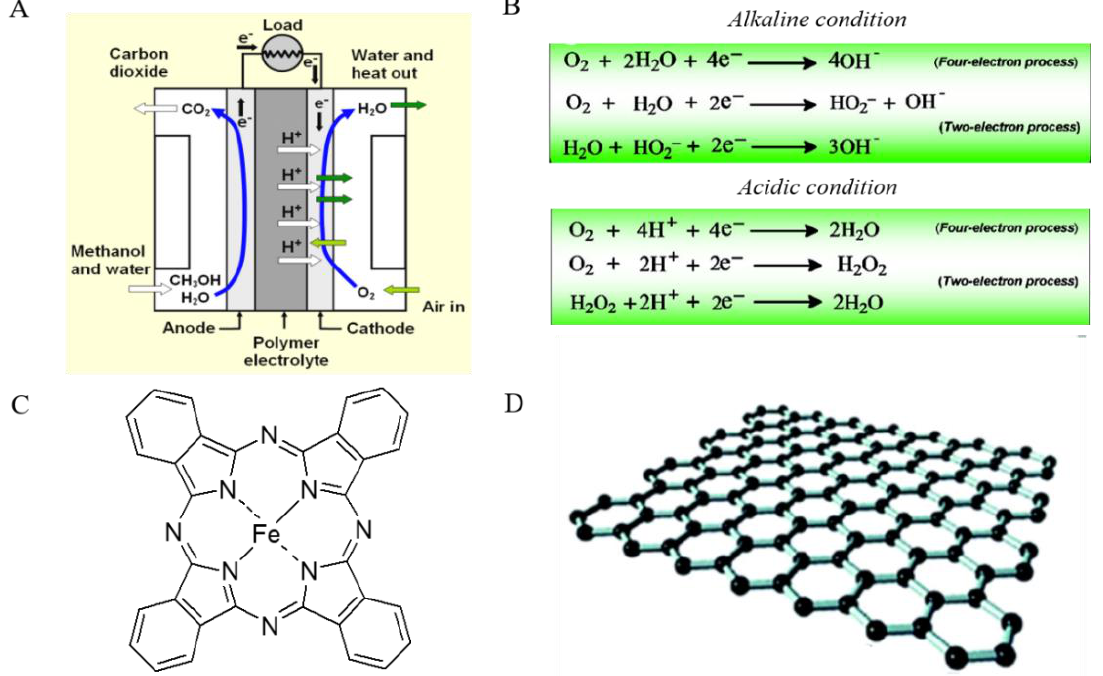
Figure 1. ( A ) Schematic of direct methanol fuel cells (DMFC), adapted from ref [23], ( B ) The oxygen reduction reaction in alkaline and acidic conditions, adapted from ref [5] Copyright 2010 American Chemical Society. Chemical structure of ( C ) iron phthalocyanine (FePc), and ( D ) two-dimensional graphene, adapted from ref [24] Copyright 2016 Elsevier.